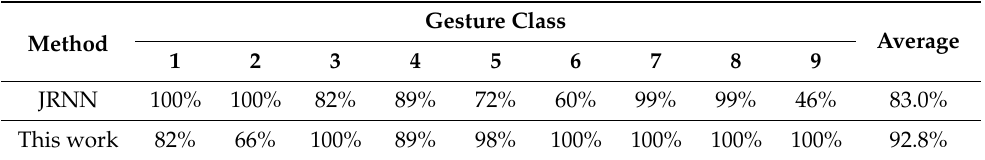
Table 1. Gesture recognition accuracies of various classifiers.